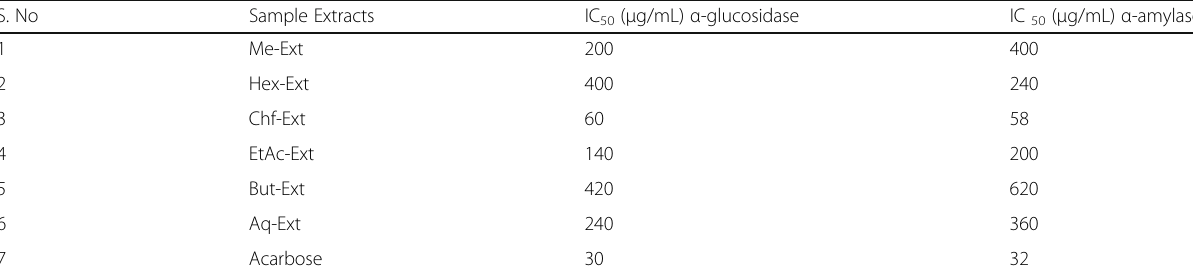
Table 4 α -Amylase and glucosidase inhibition potential of E. umbellata fruit Me-Ext and various fractions S. No